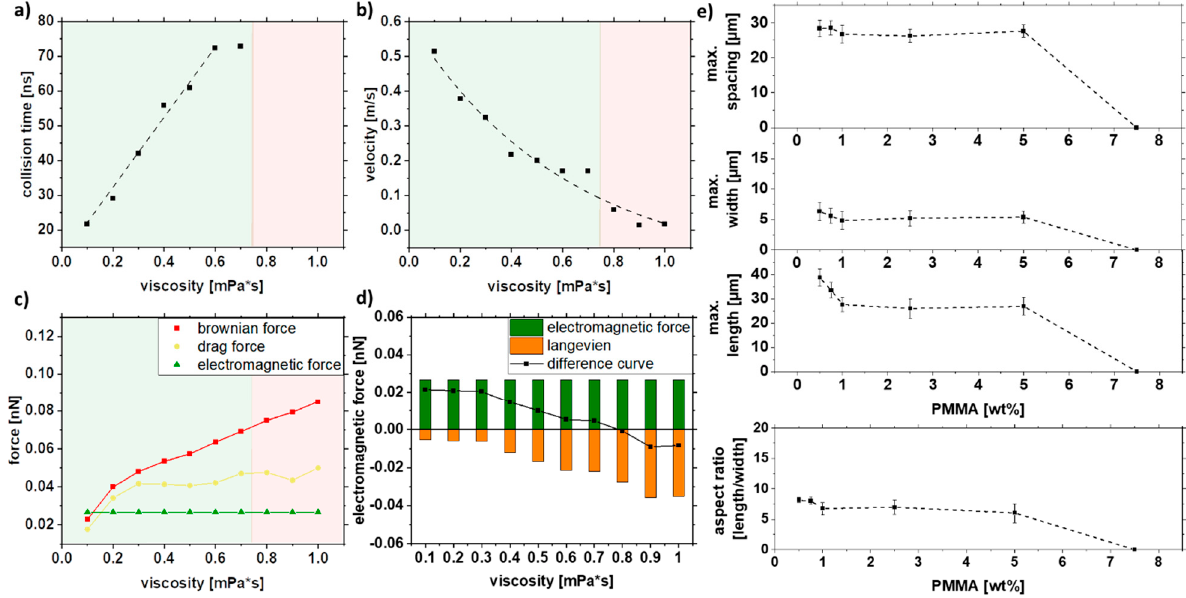
Figure 7. COMSOL simulation data of ( a ) collision time, ( b ) velocity, and ( c , d ) forces in dependence on the viscosity and experimental validation of ( e ) length, width, spacing, and aspect ratio of strands as a function of the PMMA concentration for a mean particle size of x c = 16 nm.